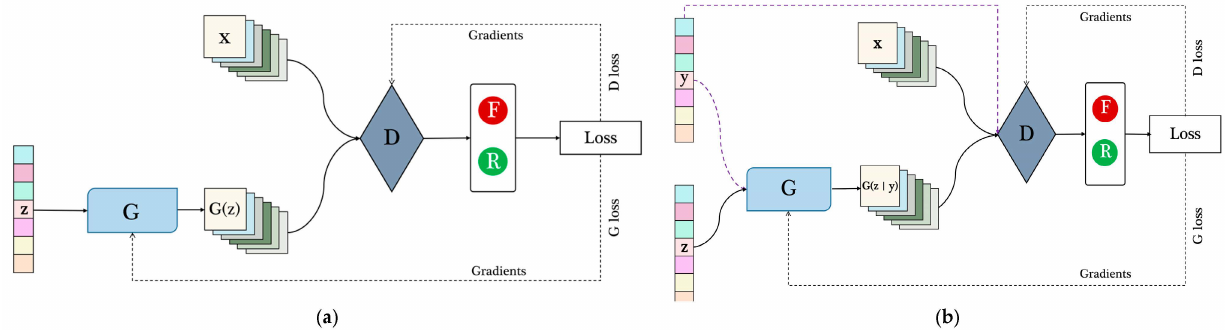
Figure 2. ( a ) The basic framework of GAN. Where G is the generator; D is the discriminator; z is generally random noise sampled from a Gaussian distribution, z generates a false sample G ( z ) after passing through the G; x is the true sample, and the discriminator makes a true or false judgment on the input sample. ( b ) The structure of CGAN. The biggest difference to traditional GAN is that the label of the sample will be used as input to both the generator and the